Question: Which visualization type does this figure use?
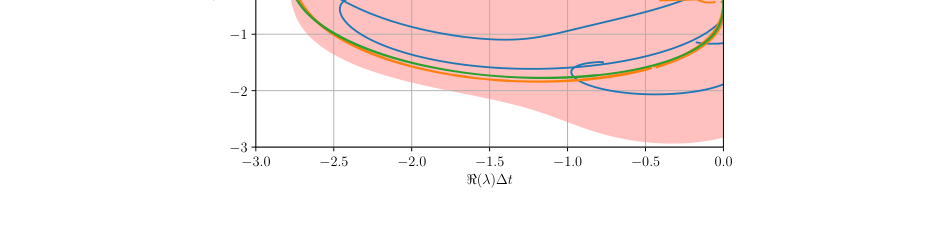
Answer: line